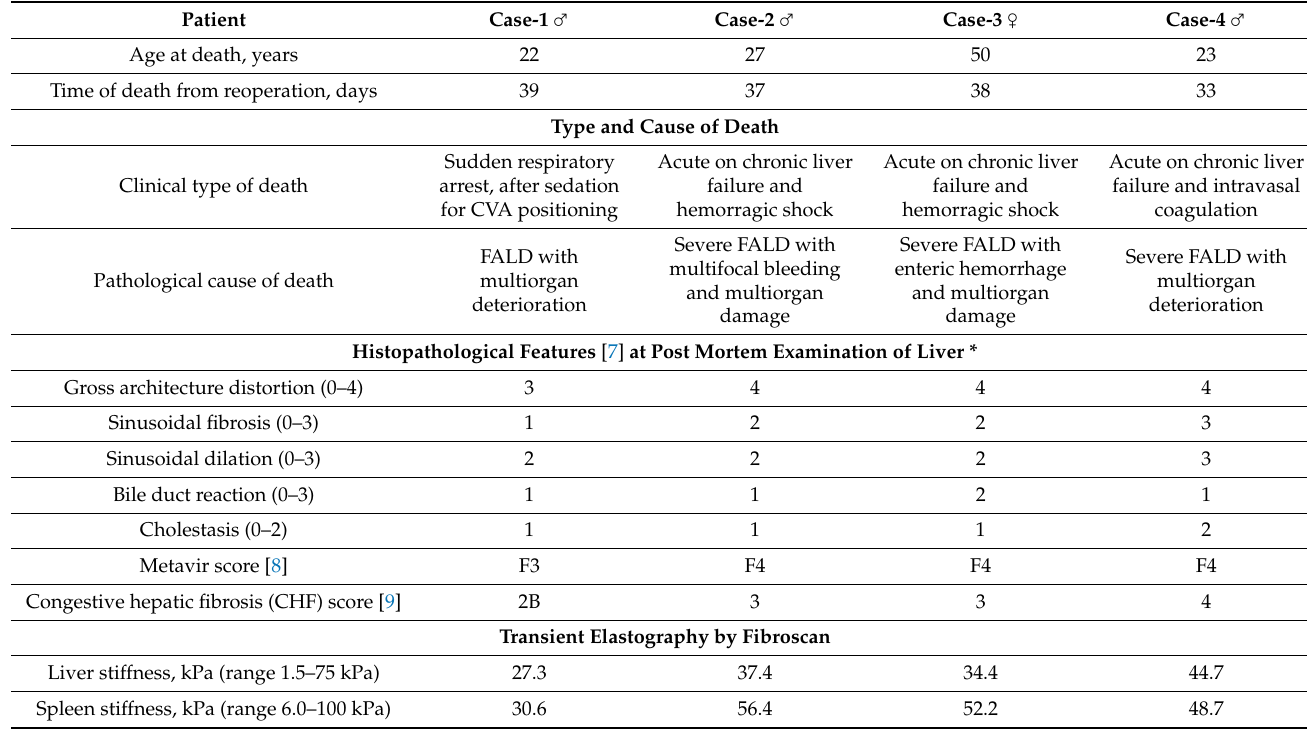
Table 2. Description of the type and cause of death in relation to liver post-mortem pathological features and to transient elastography (TE)